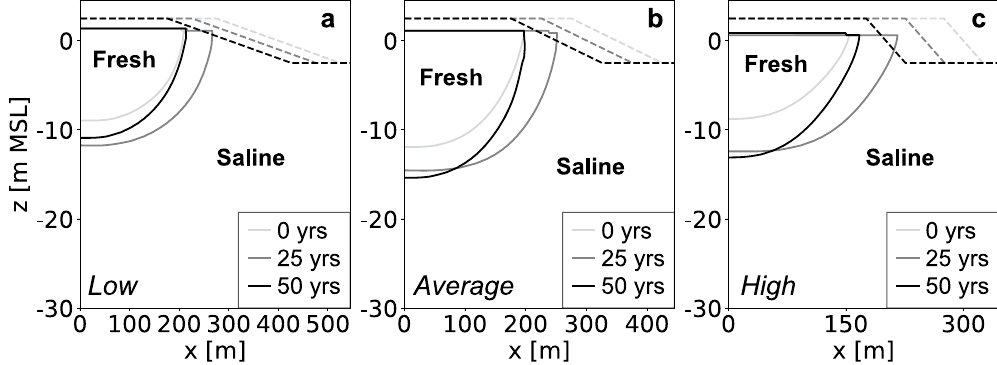
Figure 7. Simulated growth of the fresh groundwater lens for low (left), average (centre), and high (right) estimates of the slope of the nourished beach. All images show the fresh-salt groundwater interface of 1 g TDS L − 1 (solid lines) and surface elevation (dashed lines) at the start (light grey), middle (dark grey) and end (black) of the simulation period.